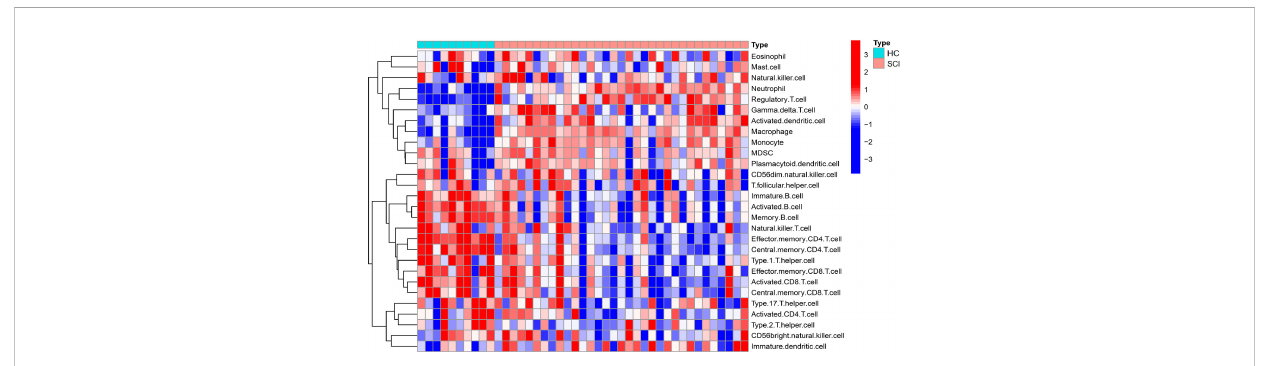
FIGURE 8 Heatmap of ssGSEA of immune cells in the SCI and HC groups. SCI, spinal cord injury; HC, healthy uninjured control. ssGSEA, single-sample gene set enrichment